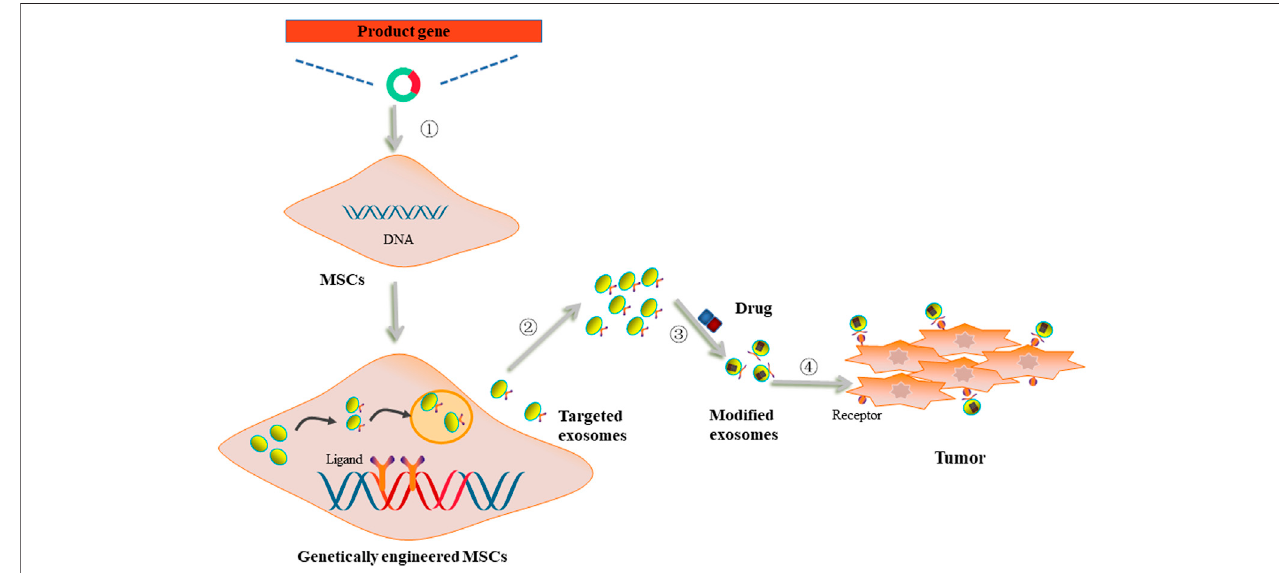
FIGURE 3 | The utilization of genetically engineered MSCs-derived exosomes as drug carriers. ① MSCs were transfected with vectors carrying product genes. ② Genetically engineered MSCs secreted exosomes with acquired targetability to cancer cells. ③ The targeted exosomes were loaded with anti-cancer drugs. ④ Modi fi ed exosomes were internalized by cancer cells through ligand/receptor interaction to deliver drugs to exert anti-cancer effects.